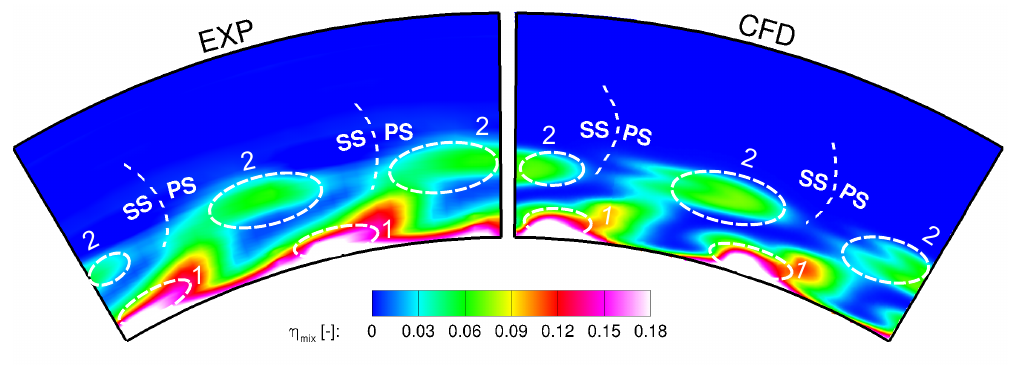
Figure 8. Comparison of flow tracing MFR 3 ( left ) and CFD predictions ( right ) of the propagation of the RIDN coolant